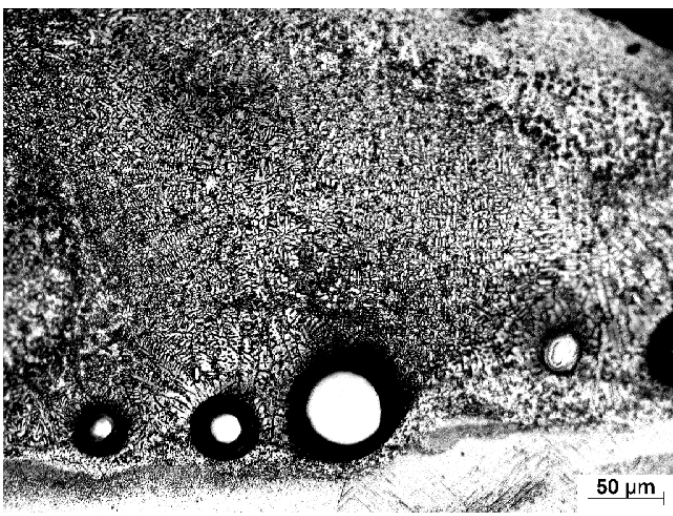
Figure 5. Light micrograph of the cross section of the laser clad samples processed at specific heat input of 119 J·mm − 2